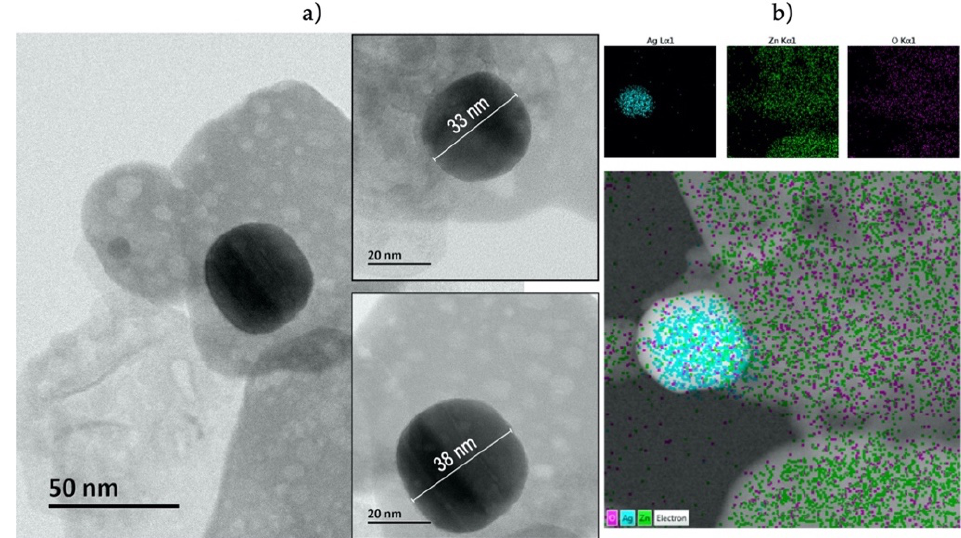
Figure 4. TEM images ( a ) and EDS mapping ( b ) of Ag/ZnO MSs obtained at 9.8 mM of AgNO 3 during 30 min.